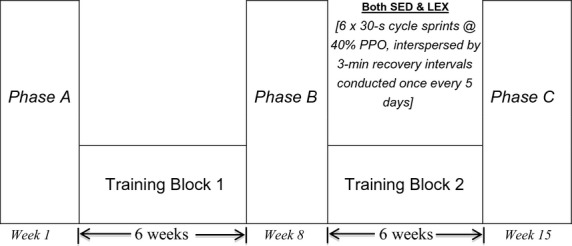
Schematic depicting study design incorporating three testing phases (A, B, and C) of two distinct
training blocks for lifelong sedentary (SED) and lifelong exercising (LEX) groups.